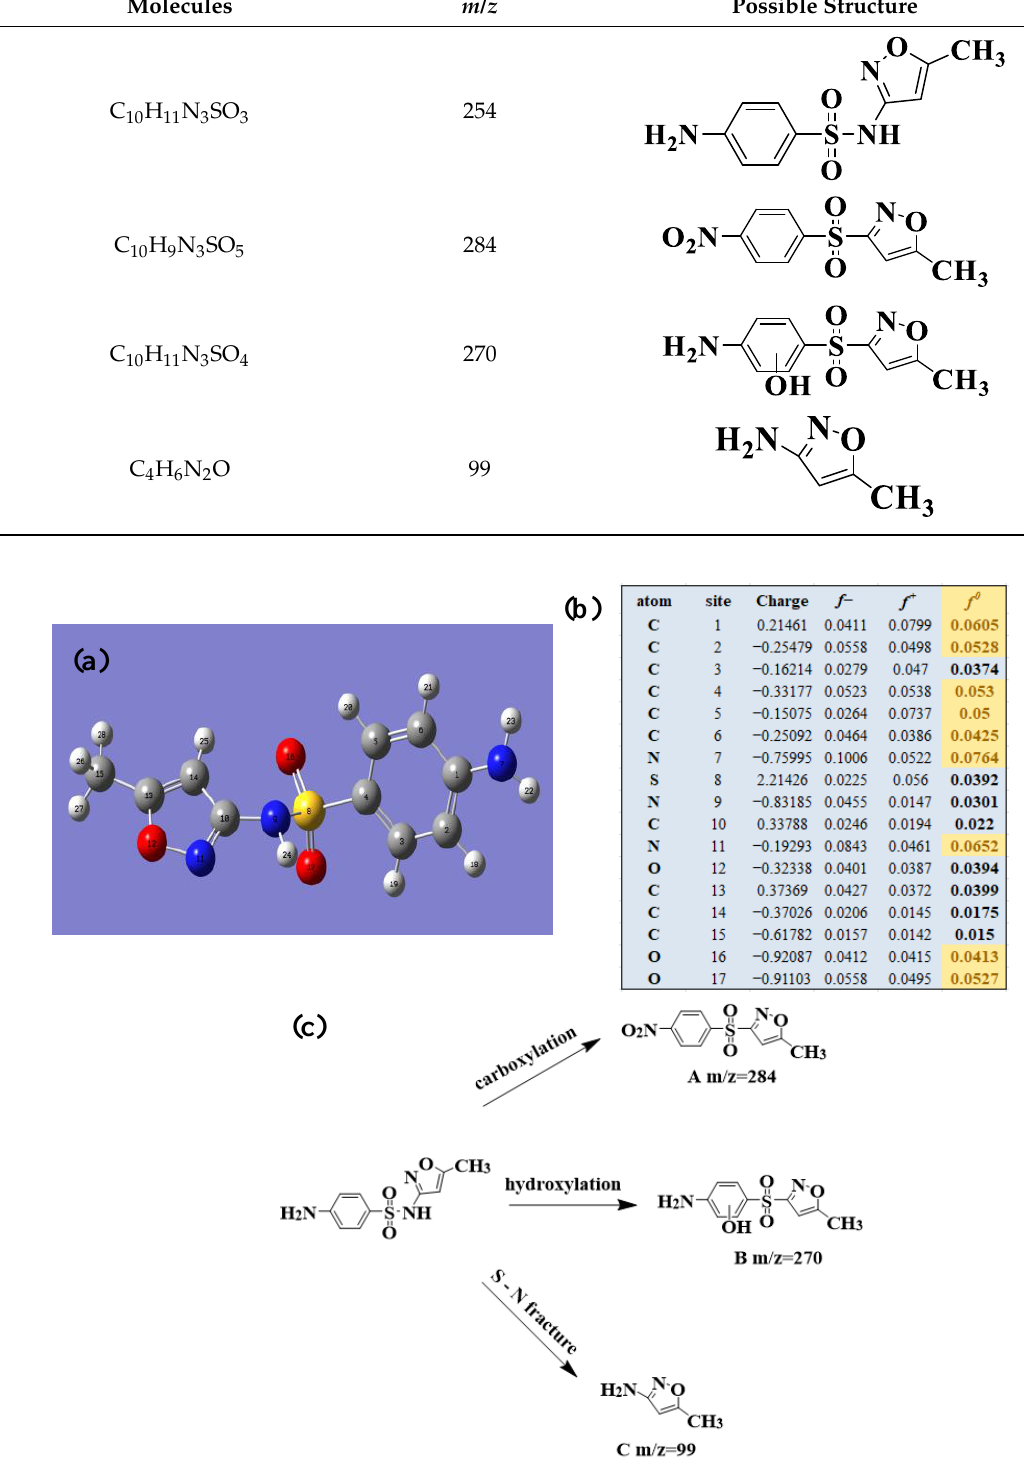
Figure 7. ( a ) Chemical structure, ( b ) NPA charge distribution and Fukui index ( f 0 ) and ( c ) degradation pathway of SMX.